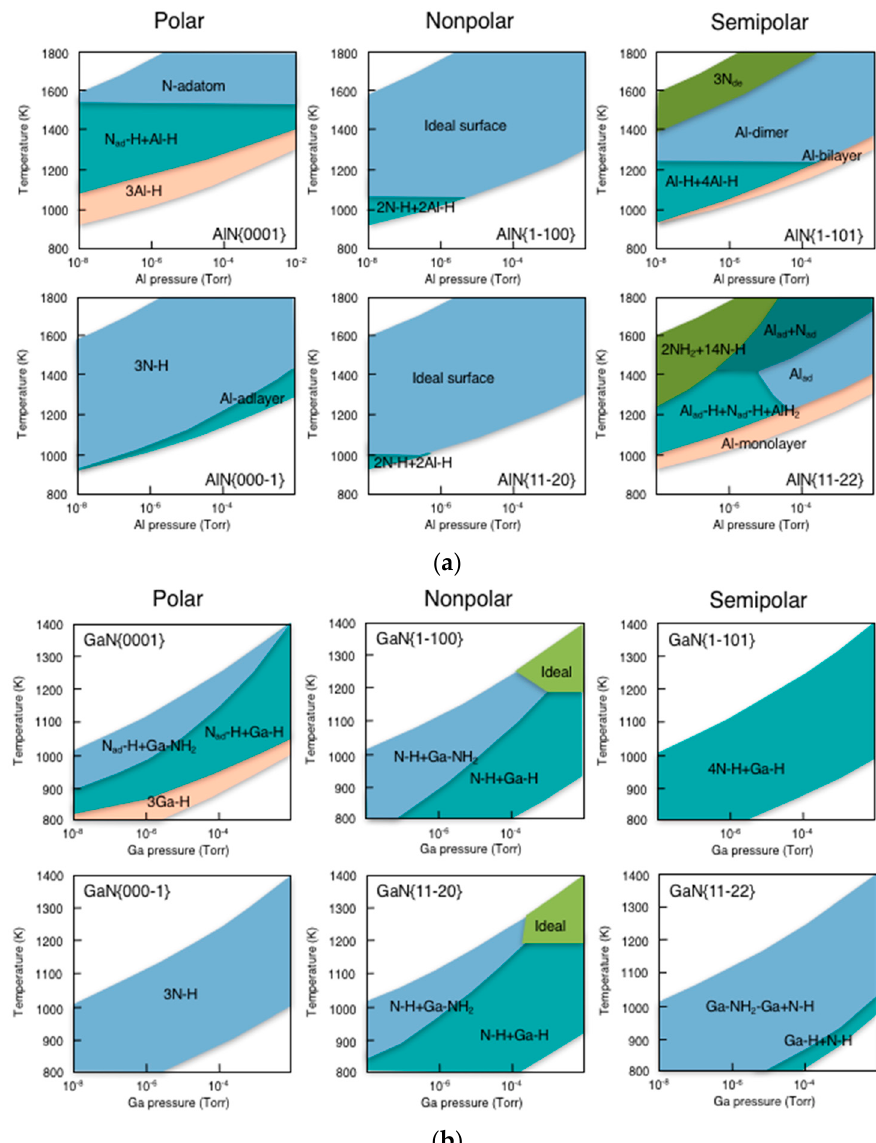
Figure 36. Surface phase diagrams for H-adsorbed ( a ) AlN and ( b ) GaN with different orientations as functions of temperature and pressure.